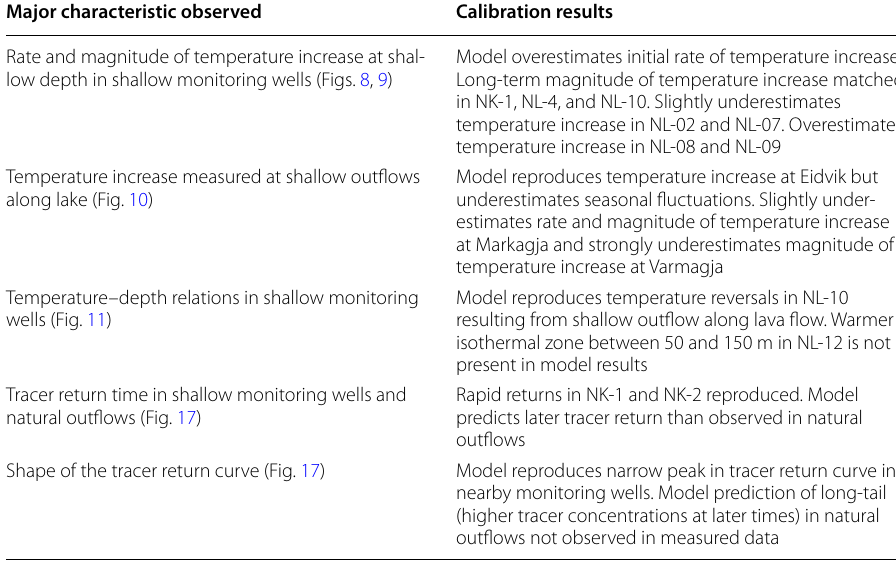
Table 3 Major characteristics observed by the field data and calibration results Major characteristic